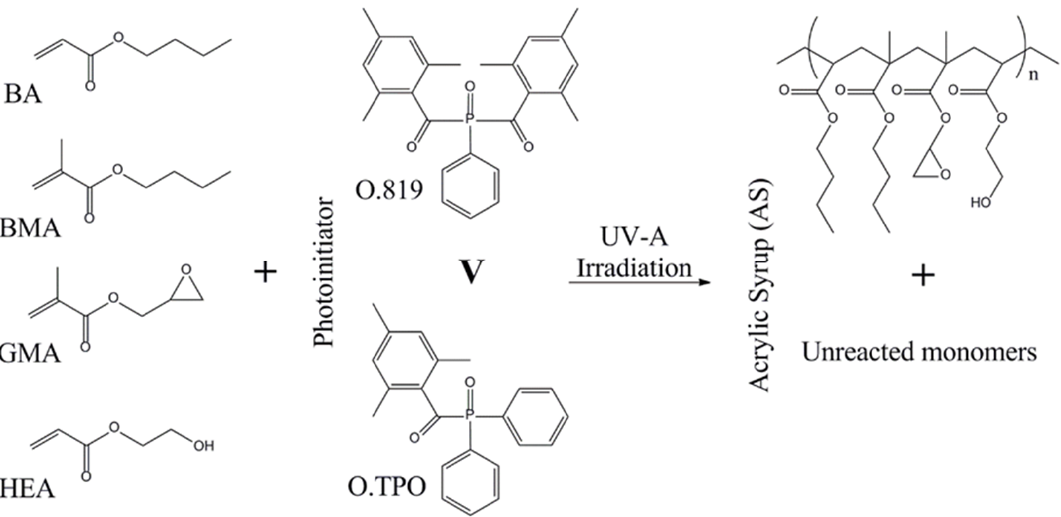
Figure 1. Schematic chemical structures of the tested monomers, photoinitiators, and the prepared acrylic syrups (BA: n-butyl acrylate, BMA: butyl methacrylate, GMA: glicydyl methacrylate, HEA: hydroxyethyl acrylate, O.819: Omnirad 819, O.TPO: Omnirad TPO).